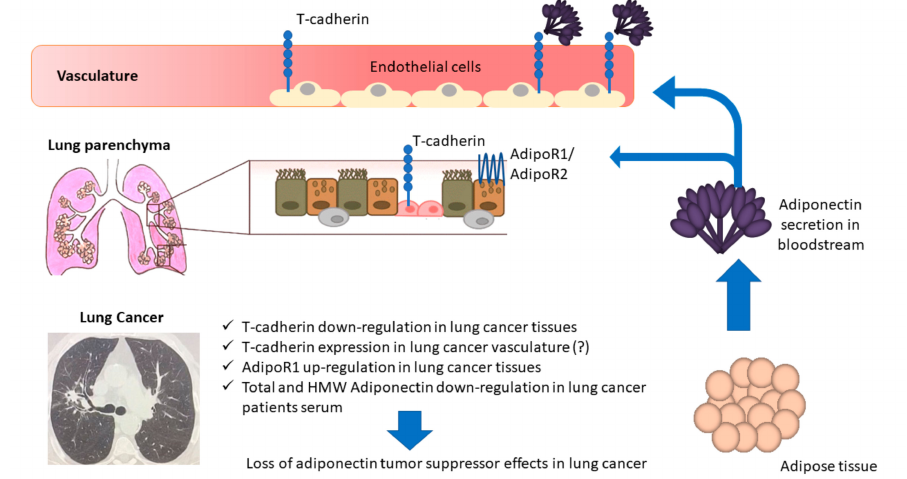
Figure 3. The down-regulation of T-cadherin in lung cancer tissues has been reported to be associated with an up-regulation of T-cadherin in the vasculature that could partially determine a reduction in Acrp30 production by the local infiltrating adipose tissue; this decrease of local Acrp30 in turn determines AdipoR1 up-regulation. On the other hand, Acrp30 levels may be regulated by other factors, such as pro-inflammatory cytokines acting on adipose tissue; low levels of Acrp30 a ff ect the expression levels of its receptors in lung tissues, which may have implications in TME regulation, also through the down-regulation of T-cadherin and up-regulation of